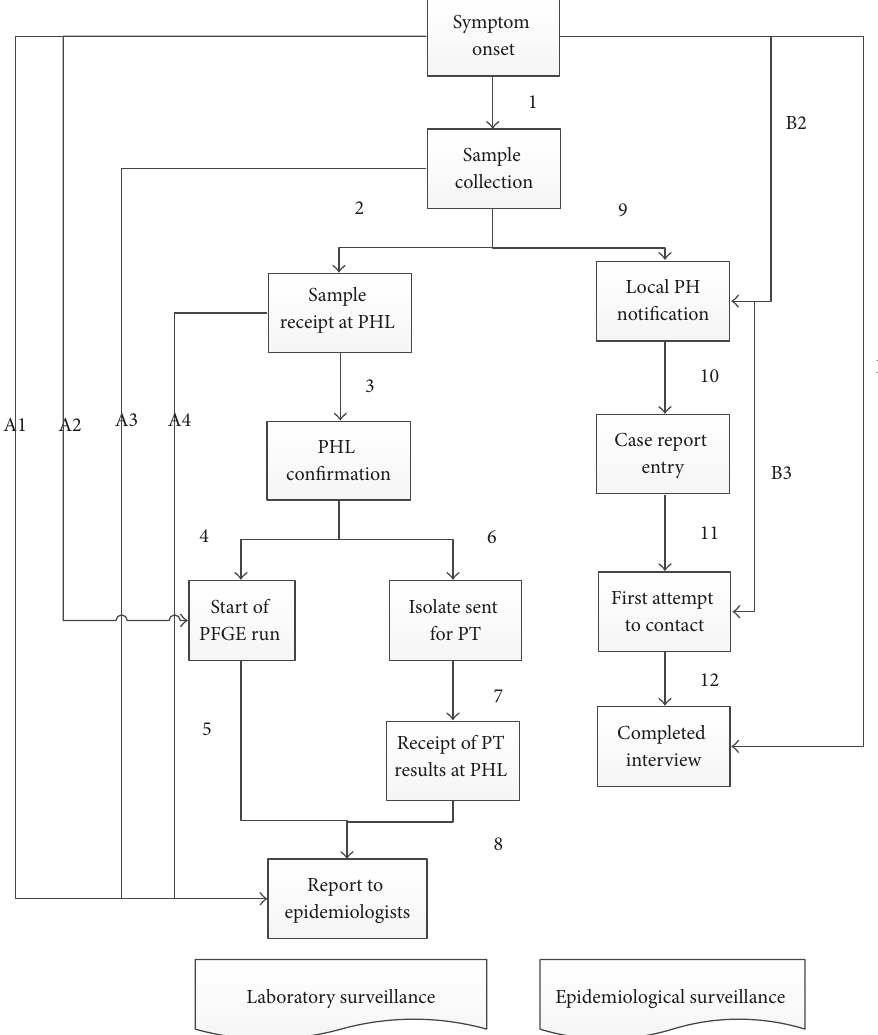
Figure 1: Enteric disease surveillance process and time intervals measured, British Columbia. PH: public health, PHL: public health laboratory, PFGE: pulsed-field gel electrophoresis, PT: phage type.